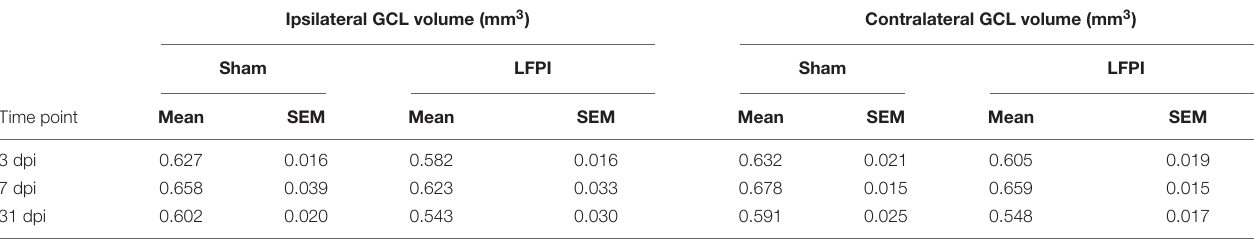
TABLE 1 | Granule cell layer (GCL) volume in the ipsilateral and contralateral hemispheres, 3, 7, and 31 days post-injury (dpi).